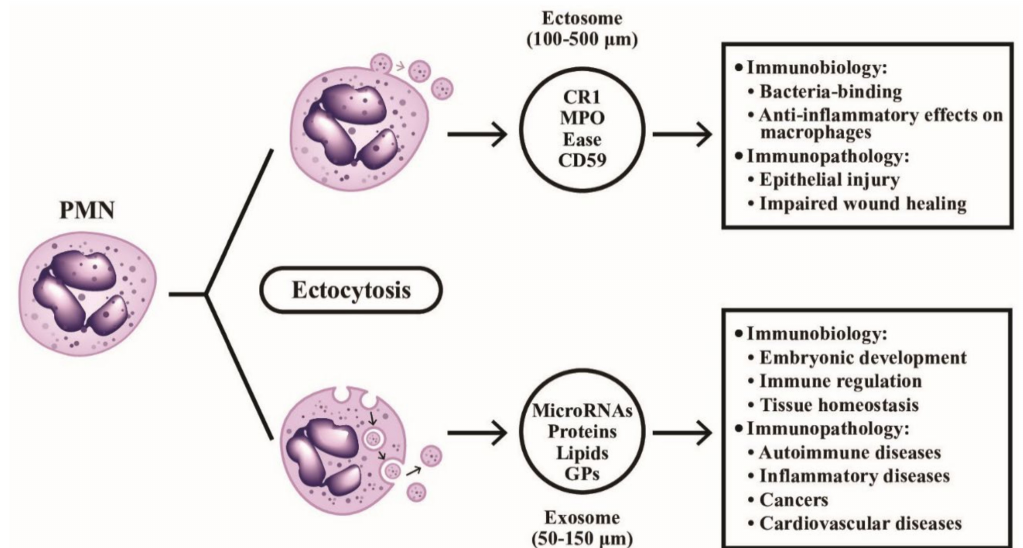
Figure 4. The formation, particle size, contents, and detailed immunobiological/immunopathological functions of ectosomes and exosomes extruded from PMN are demonstrated. The ectosomes are microvesicles containing granule proteins and surface membrane-expressed components such as complement receptors and CD59. The ectosomes directly detach from cell surface without deepening into cytoplasm. On the contrary, exosomes vaginate inward into the cytoplasm and take up cytoplasmic DNAs, RNAs, glycoproteins and lipids before extrusion from the cells. CR1: complement receptor type 1; MPO: myeloperoxidase; Ease: elastase; GP: glycoprotein; CD: cluster of